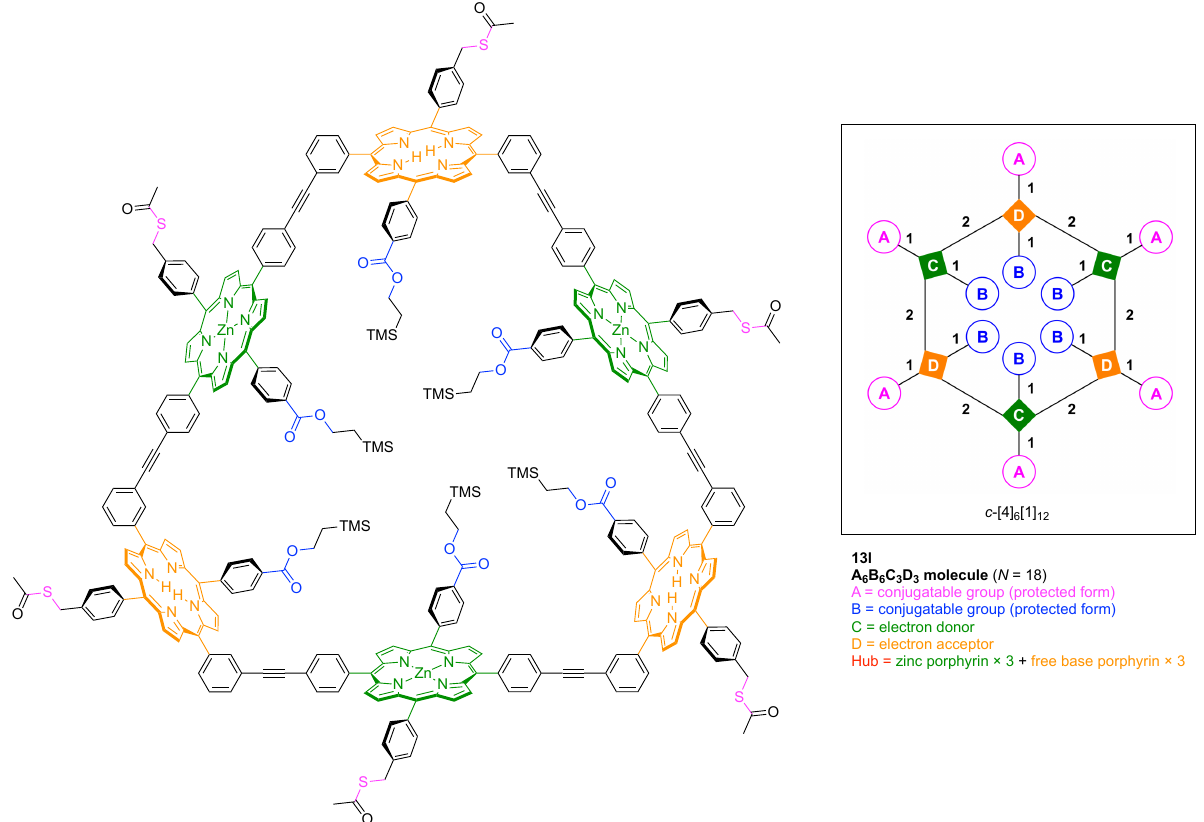
Figure 72. A shape-persistent macrocycle with 12 derivatizable groups.